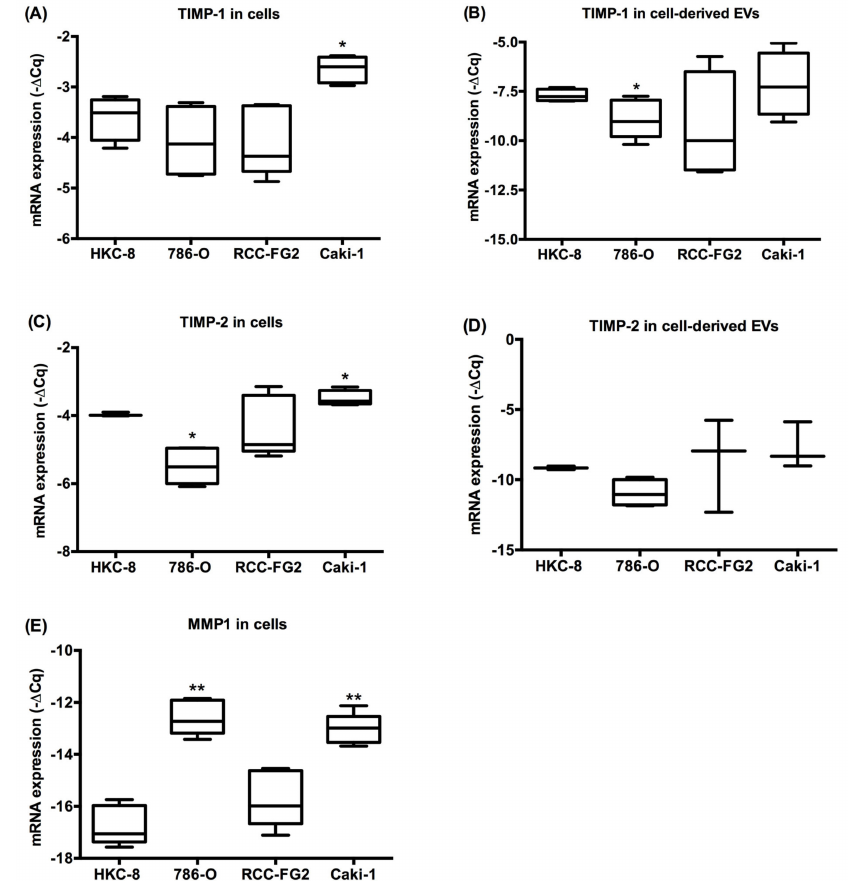
Figure 3. TIMP-1, TIMP-2 and MMP-1 mRNA expression intracellularly ( A , C and E ) and in EVs ( B and D ) derived from HKC8, 786-O, RCC-FG2 and Caki-1 cell lines. (Mean ± Std. Error; * p < 0.05, ** p < 0.001). Five biological replicates of each cell line were used for this